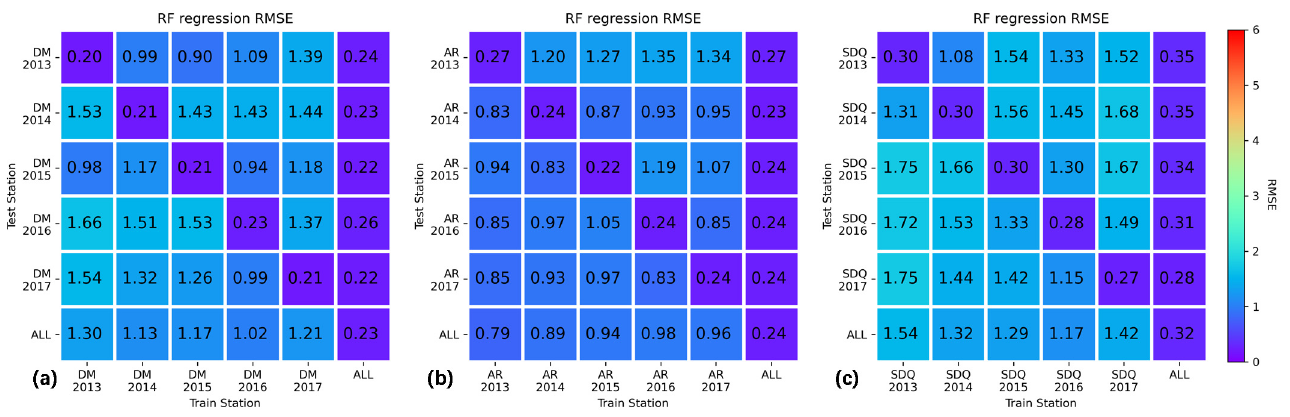
Figure 8. The RMSEs of predicted results by RF regression method using training and test data from same stations during different years. ( a – c ) correspond to DM, AR, and SDQ stations, respectively.